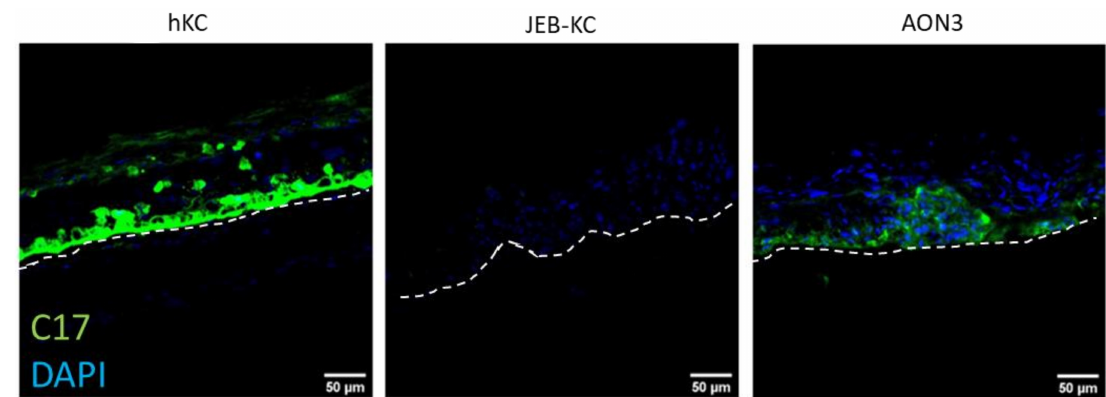
Figure 3. Generation of 3D skin equivalents from AON-treated JEB-KC. Skin equivalents were generated from hKC and JEB-KC. Upon treatment with AON3, the deposition of C17 became detectable within the basal layer of the epidermis. Scale bar: 50 µ